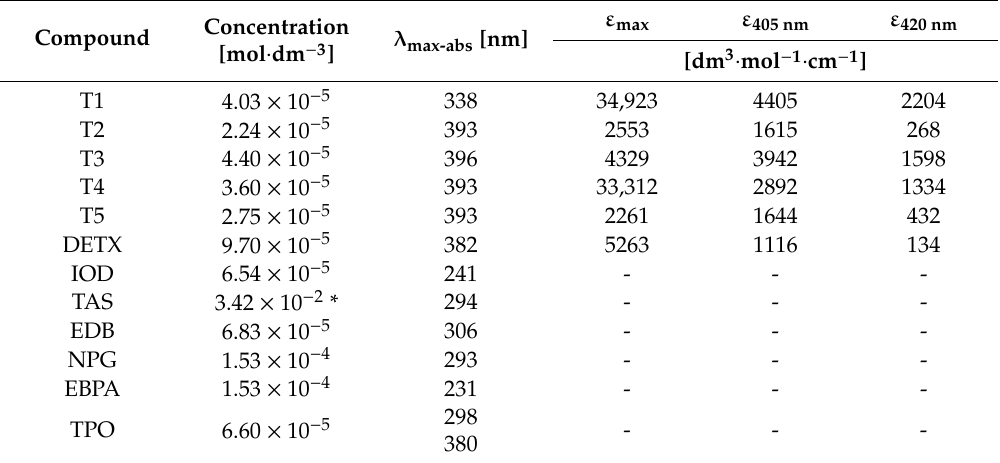
Table 1. Light absorption data of 2,4-diethyl-thioxanthen-9-one derivatives in acetonitrile: maximum absorption wavelengths ( λ max-abs ), molar extinction coe ffi cients ( ε ) at λ max and at the maximum of the emission wavelengths of the LEDs 405 nm and 420 nm.